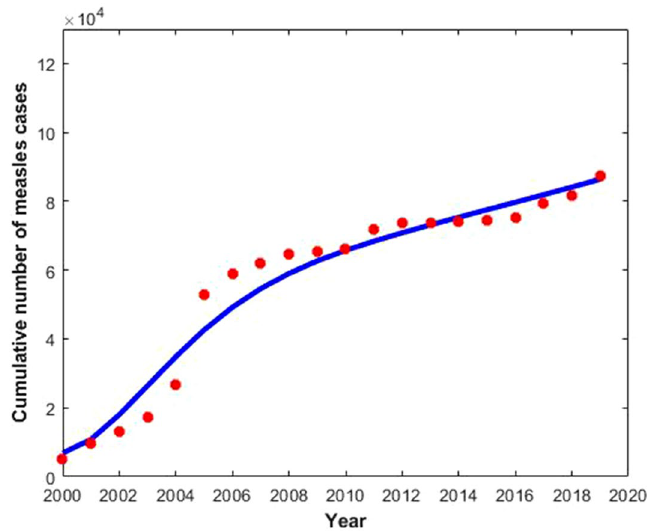
Figure 4. Cumulative number of confirmed measles cases from 2000 to 2019 (red dot) and the corresponding model best fit (solid blue curve) in Bangladesh.